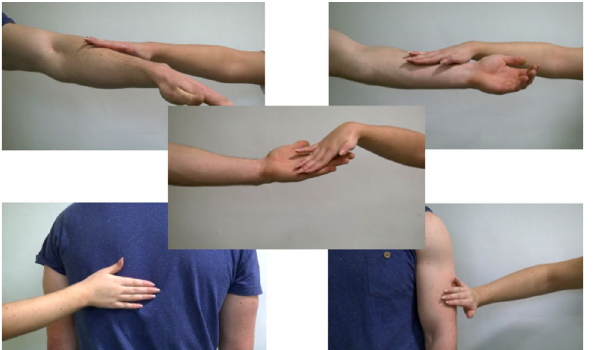
Figure 1. Stills from the videos presented, one depicting each of the 5 locations studied. The clips lacked any social context, faces were not visible, and showed only the hand and forearm of one female actor ‘the toucher’ and the relevant upper body part (back, arm or palm) or the other male actor ‘the